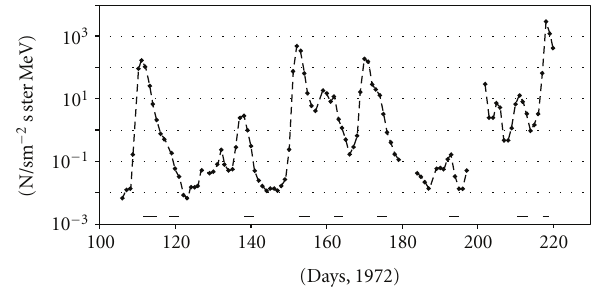
Figure16:FluxesofsolarprotonsobservedonPrognoz-1.Within70 days eight increases of SCRs were observed with exponential decay profiles (energy Ep ≈ 1MeV) of nearly identical characteristic times 𝜏 = 16.5 hours. This provides an evidence of long-term (more than two solar rotations) stationary state of the interplanetary medium in the inner